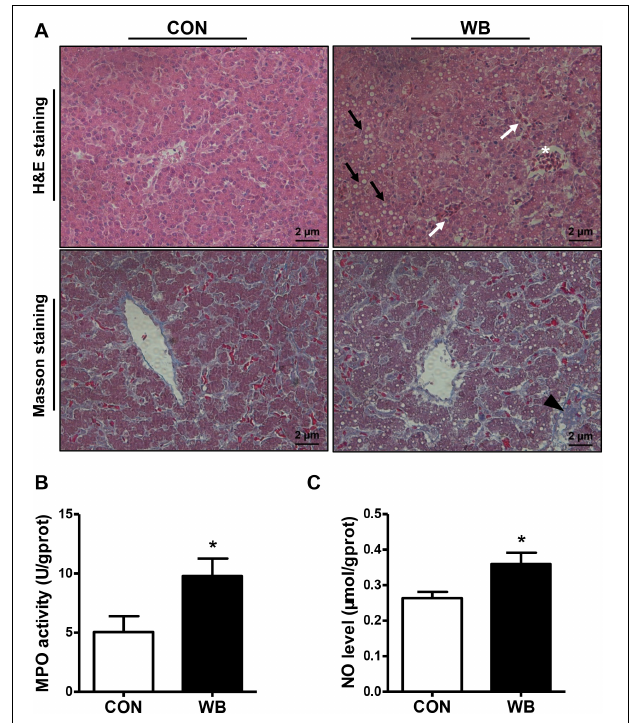
FIGURE 1 | Histopathological observation and biochemical parameters in liver tissues of broiler chickens with normal (CON) and wooden breast (WB) pectoralis major muscle. (A) Representative images of hematoxylin and eosin (H&E) and Masson staining of liver, indicating the widespread lesions with hydropic/fatty degeneration (black arrowhead), inflammatory cell infiltration (*), and intrahepatic hemorrhages (white arrowhead) as well as occasional fibrosis (black triangle) in WB. (B) Myeloperoxidase (MPO) activity and ( C ) nitric oxide (NO) level. Data are expressed as the mean ± SE ( n = 10). * P < 0.05.